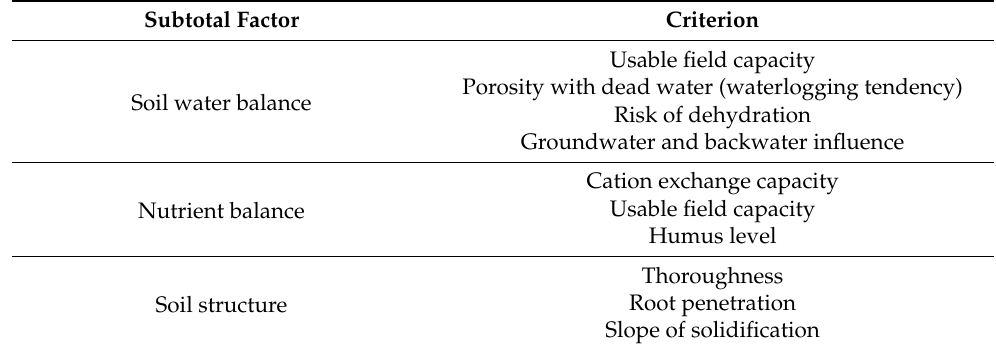
Table 6. Rules for merging the criteria for the overall classification of soil-specific biomass